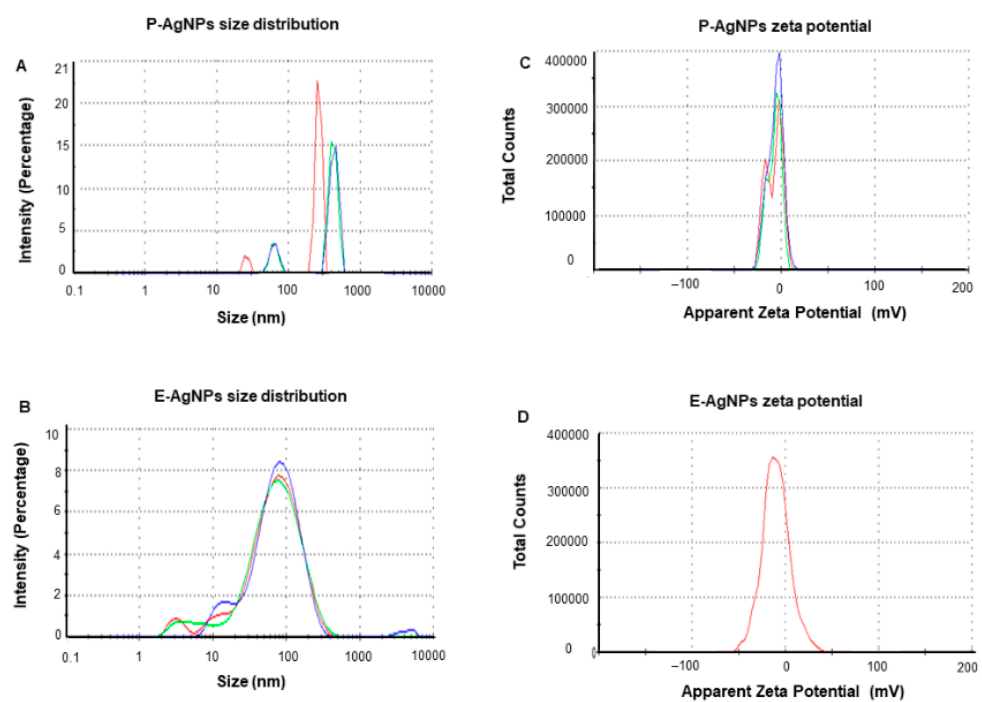
Figure 6. Dynamic light scattering analysis of P-AgNPs and E-AgNPs. ( A ) P-AgNPs distribution concerning size and intensity ( B ) E-AgNPs distribution concerning size and intensity. ( C ) The zeta potential of P-AgNPs and ( D ) E-AgNPs represents a highly negative surface charge. All the measurements were done in triplicates, and the data was calculated as the mean value.